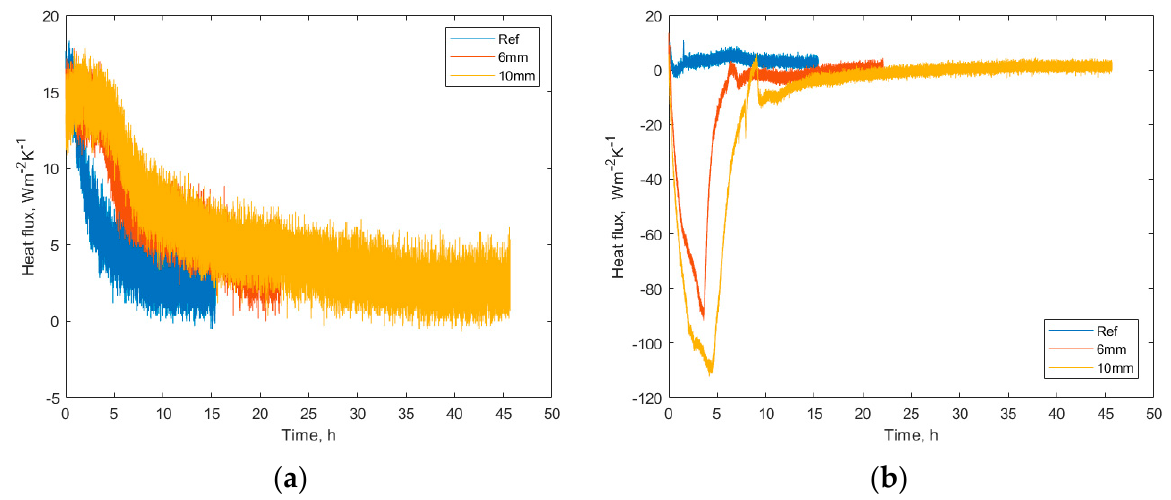
Figure 8. ( a ) The plots of changes in the heat flux at the Q1 measurement point for the three tested variants of the wall of the refrigerated trailer; ( b ) The plots of changes in the heat flux at the Q2 measurement point for the three tested variants of the wall of the refrigerated trailer.